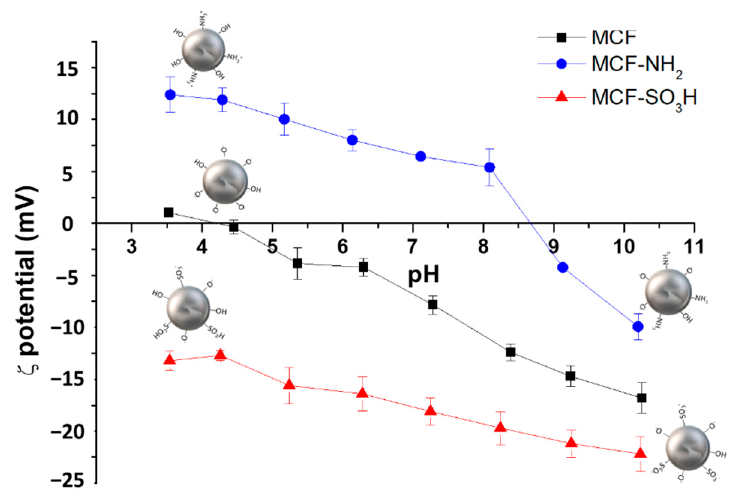
Figure 8. ζ -potential curves as a function of pH for MCF silicas before and after functionalization with APTES (MCF-NH 2 ) and MPTMS (MCF-SO 3 H).